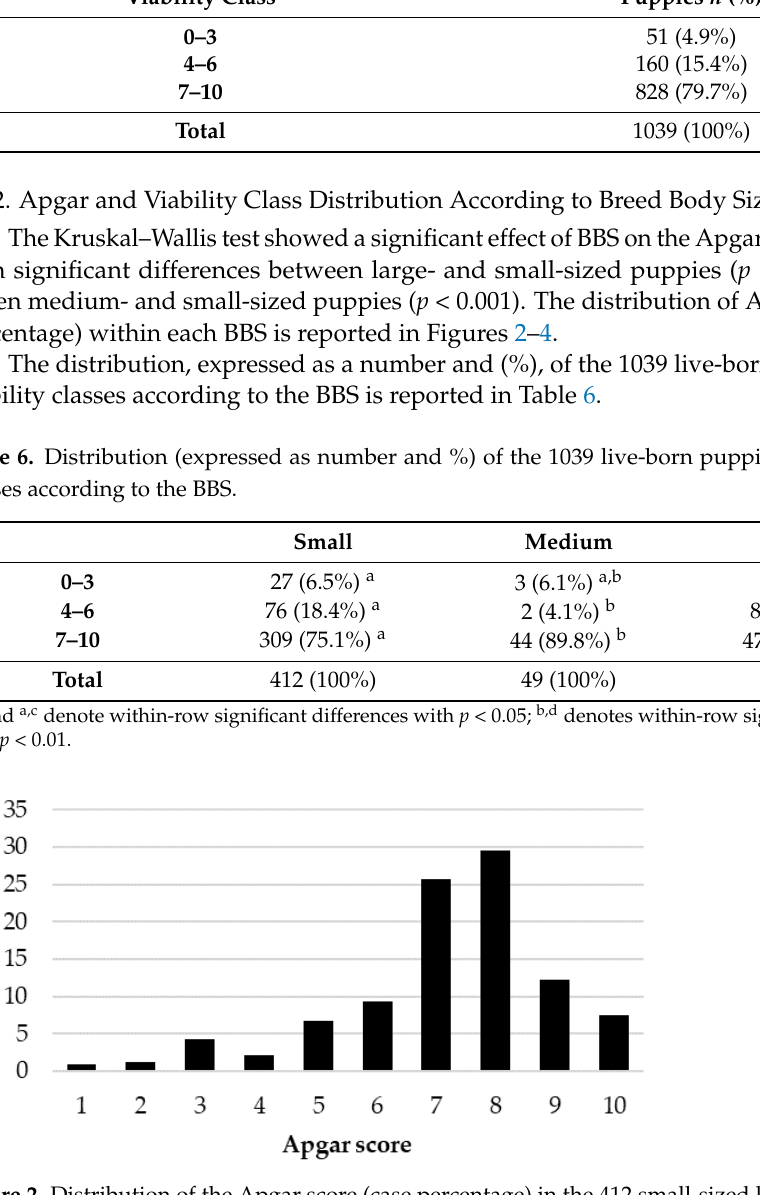
Figure 2. Distribution of the Apgar score (case percentage) in the 412 small-sized live-born puppies.